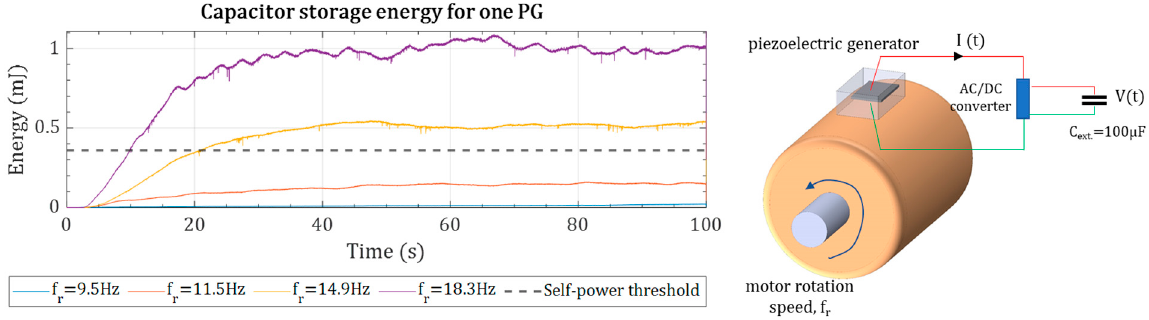
Figure 14. The stored energy for a 100µF capacitor at different motor rotation speeds.